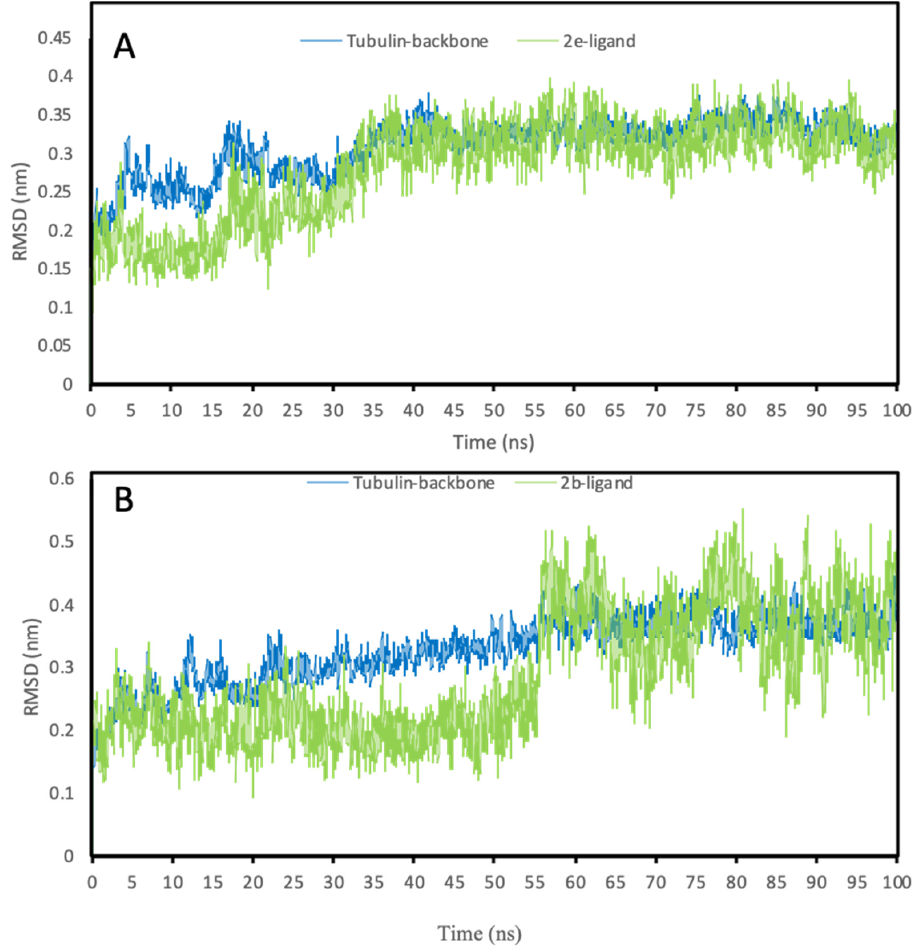
Figure 7. The time series related to RMSD values within the MD simulation trajectory. The RMSD plots for ( A ) 2b-tubulin complex and ( B ) 2e-tubulin complex at 300 K temperature for 100 ns of simulation trajectory. The figures represent the RMSD plots of proteins’ backbones (blue) and ligands (green).